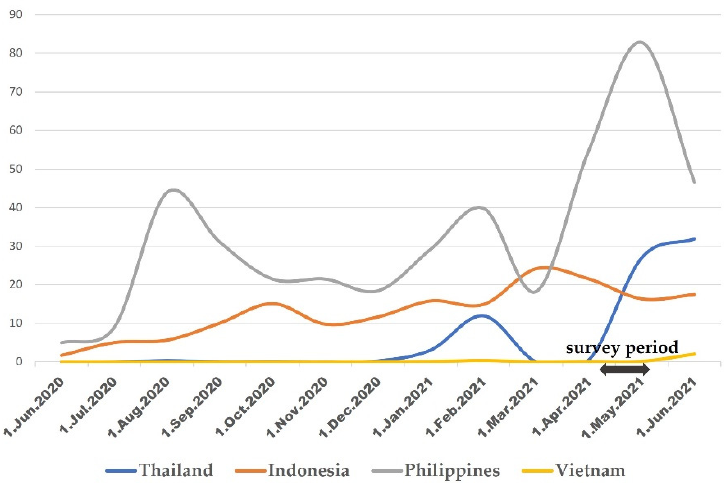
Figure 1. Number of new infections.